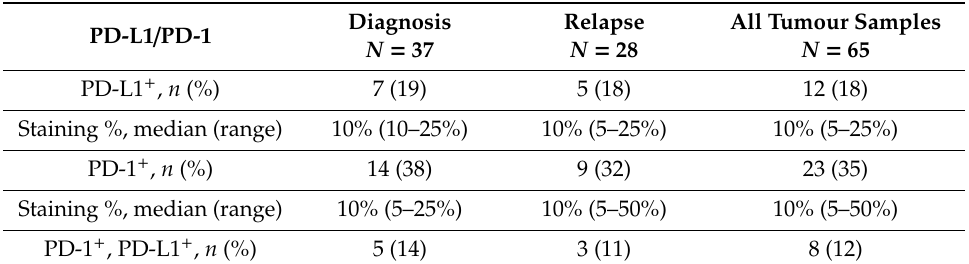
Table 2. PD-1 and PD-L1 expression analysis in MCL samples.